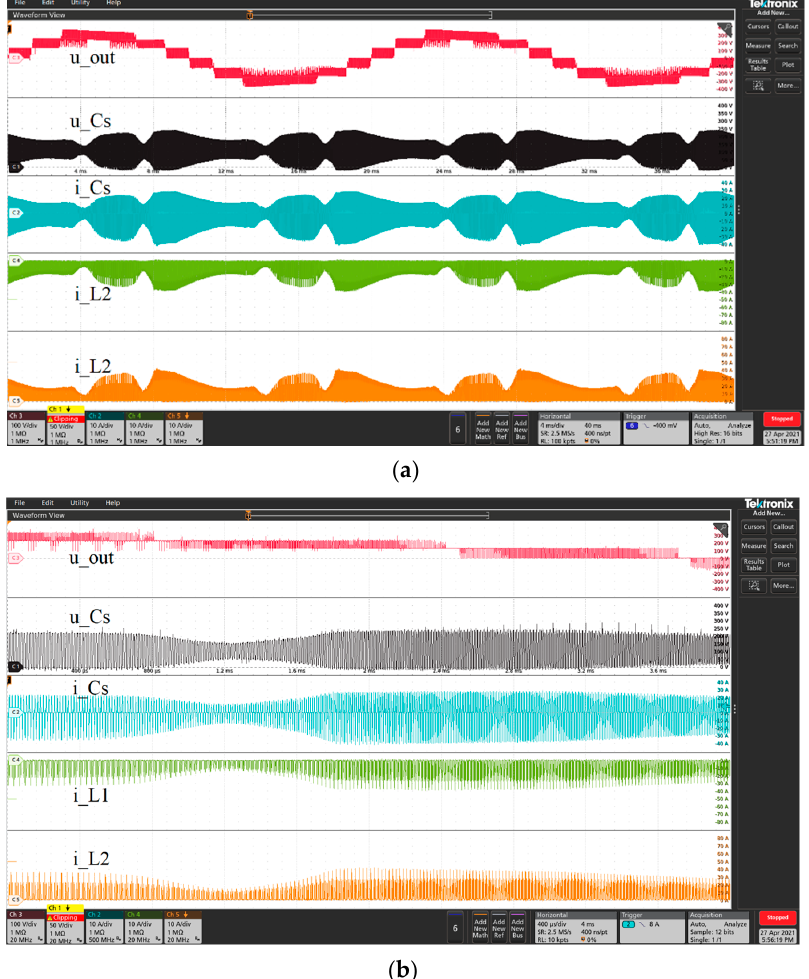
Figure 26. Operation of the DC-AC converter in the case of controlled switching frequency of the AIVB. Waveforms of the output voltage of the inverter ( u out [100 V/div]), and voltage and current of the switched capacitor ( u CS [50 V/div], i CS [10 A/div]), as well as currents of resonant chokes ( i L1 [10 A/div], i L2 [10 A/div]). Waveforms’ time span: 40 ms ( a ) and 4 ms ( b ).